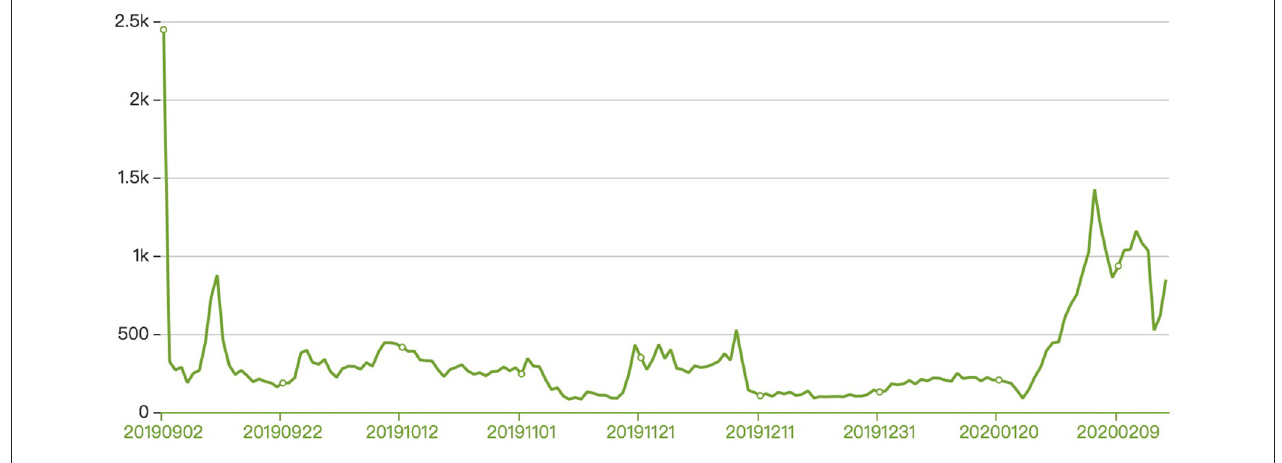
FIGURE 1 | Applications from January 31 to February 14 of 2020.